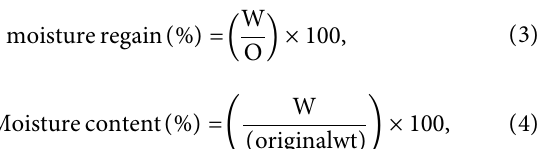
Figure 2: Schematic representation of chemical analysis of CDA